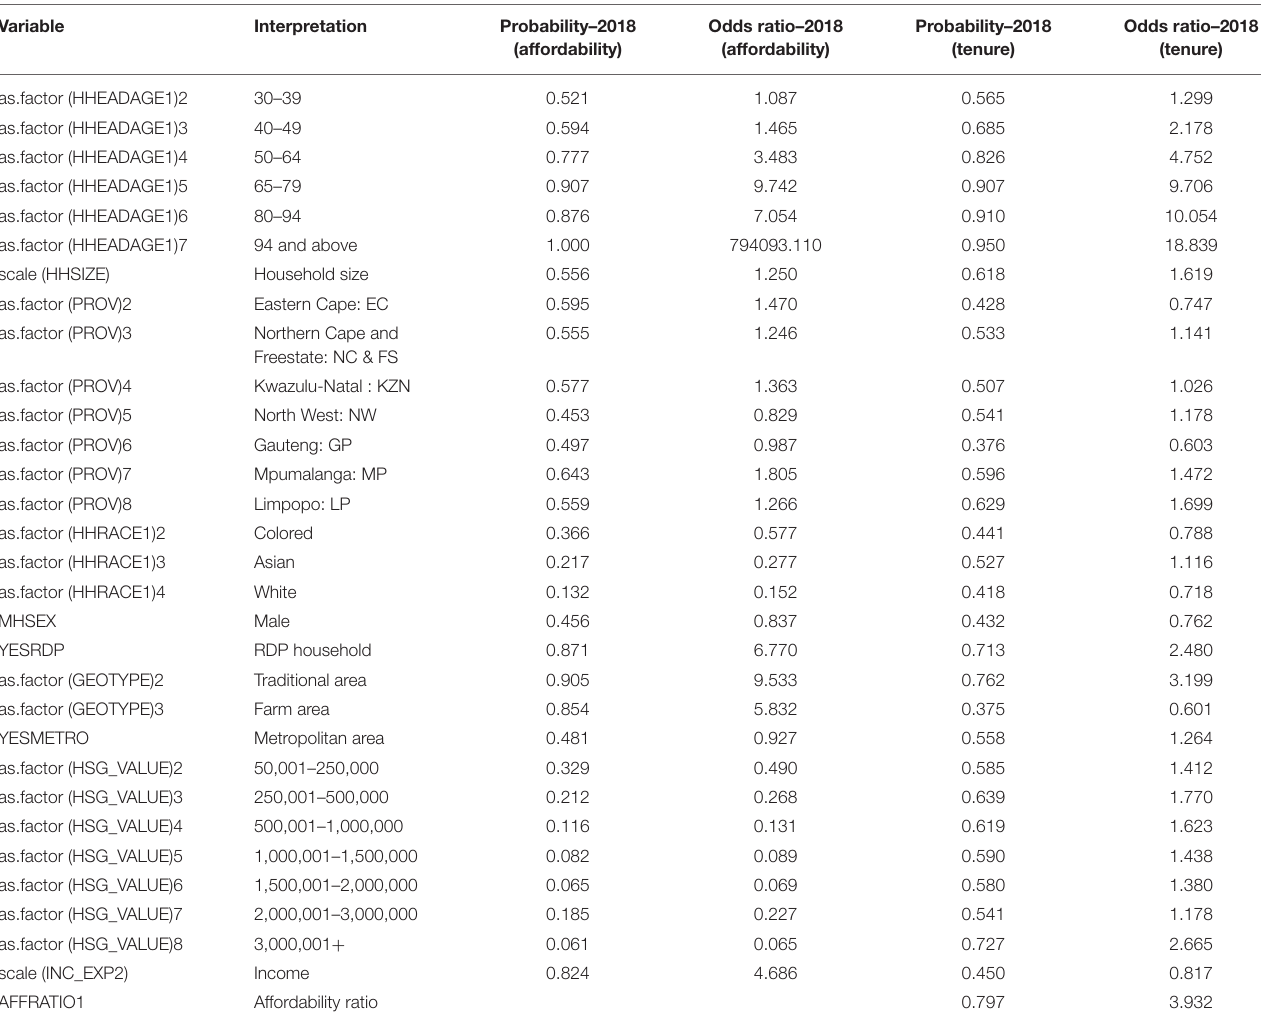
TABLE 7 | Odds ratios and corresponding probabilities for the 2018 dataset.